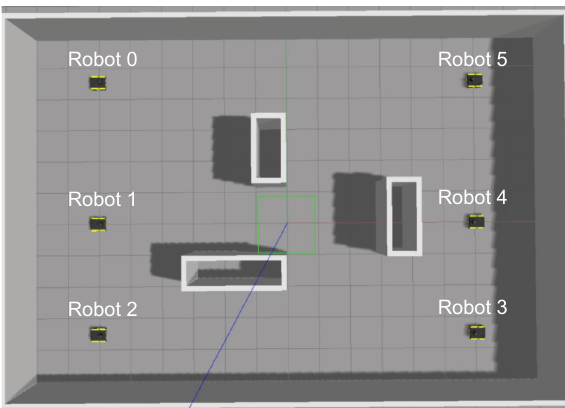
Fig. 11 Complex working scenarios built with